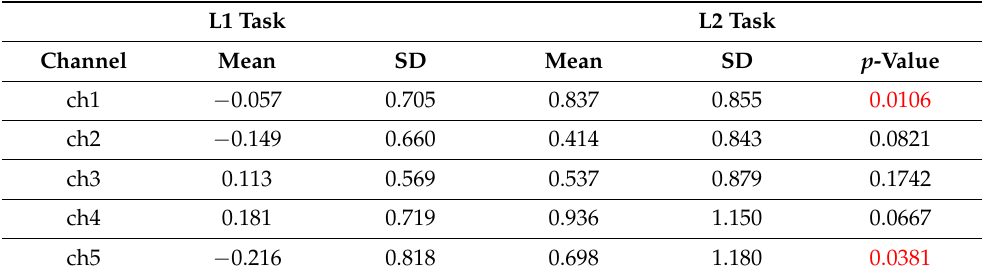
Table 4. Values of ∆ oxy-Hb at 22 channels in low-L2-ability speakers when speaking Mandarin (L1) or Japanese (L2). Red indicates significant between-task differences ( p <